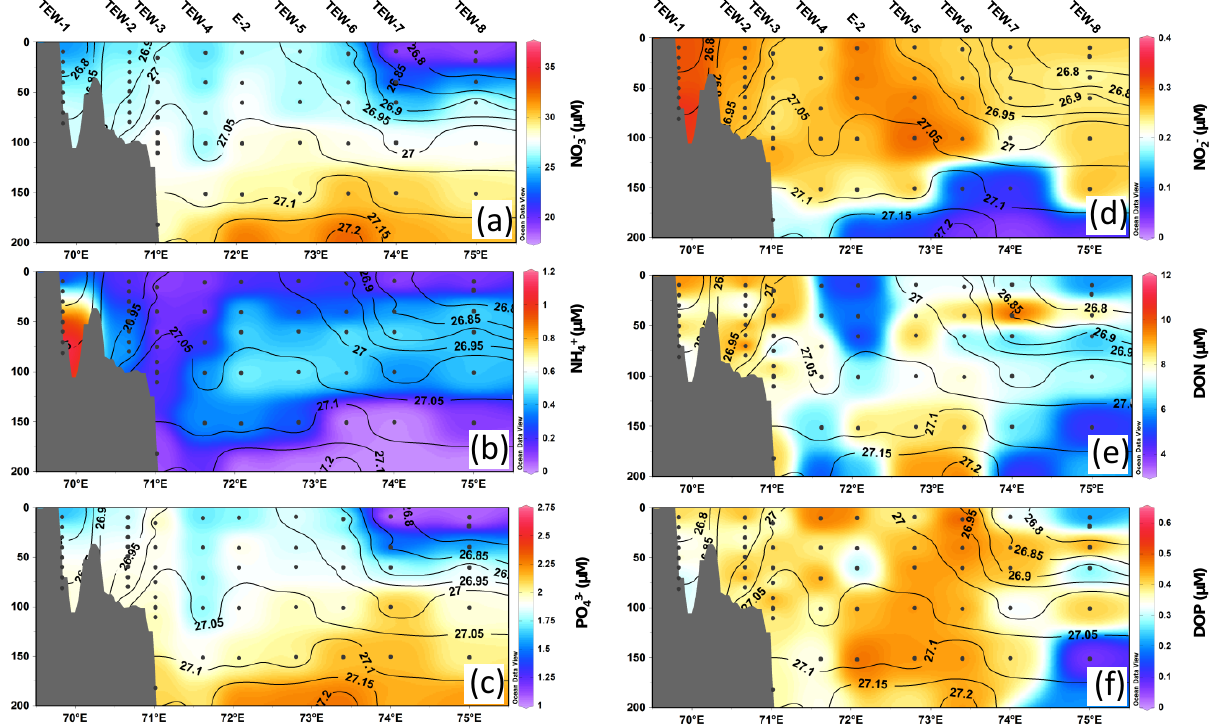
Figure 2. Vertical sections of dissolved nitrogen and phosphorus species along the East-West transect (TEW). (a) nitrate, (b) ammonium, (c) phosphate, (d) nitrite, (e) dissolved organic nitrogen, (f) dissolved organic phosphorus. The isolines for density anomaly ( σ ) are plotted on each